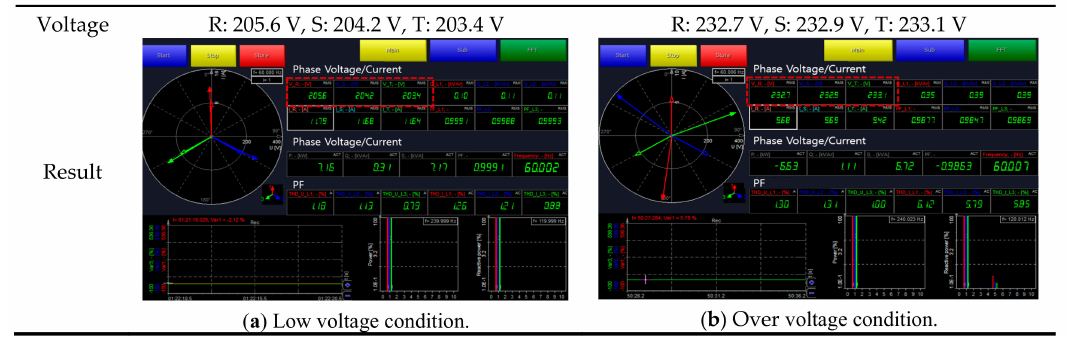
Figure 23. Test results of the customer voltage characteristic by only SVR (assumed) operation.